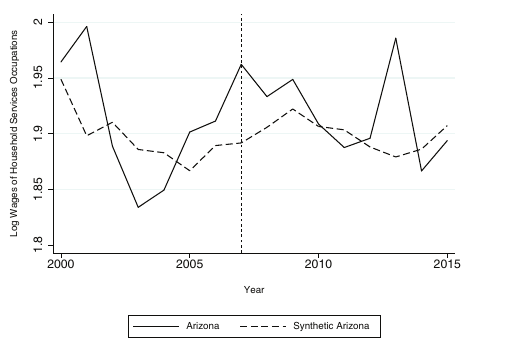
Figure 9 Wages in household service occupations (housekeepers, gardeners, and childcare